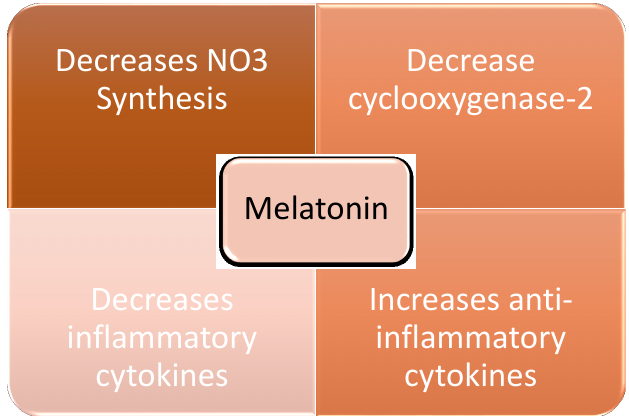
Figure 2. Melatonin properties which control oxidative stress. NO3: Nitrate.